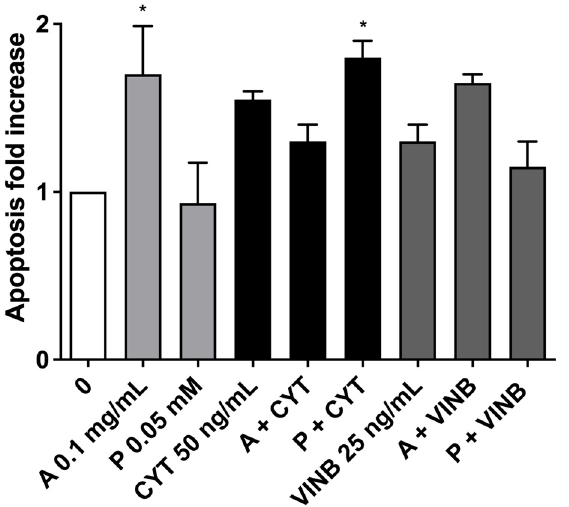
Figure 6. Cell viability ( left ) and RPD ( right ) on TK6 cells after 3 h treatments with A. leucotrichus (A) or perillaldehyde (P) followed by 23 h of recovery in the complete medium at the indicated concentrations in the presence or absence of CYT (clastogen) or VINB (aneugen) compared to the untreated cultures (0). * p < 0.05 vs. 0; ** p < 0.01; *** p < 0.001 vs. 0. On average, the apoptosis fold increase was smaller than a doubling for all the experimental conditions (Figure 7).